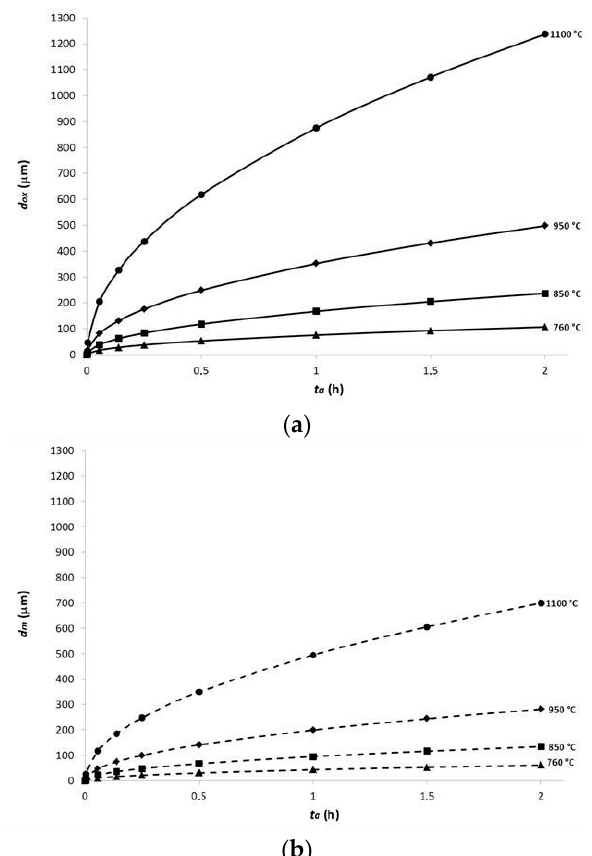
Figure 3. Oxidation of iron during the annealing in air (our experimental conditions). ( a ) Calculated thickness of the oxide layer d ox , ( b ) calculated thickness of the oxidized iron d m.